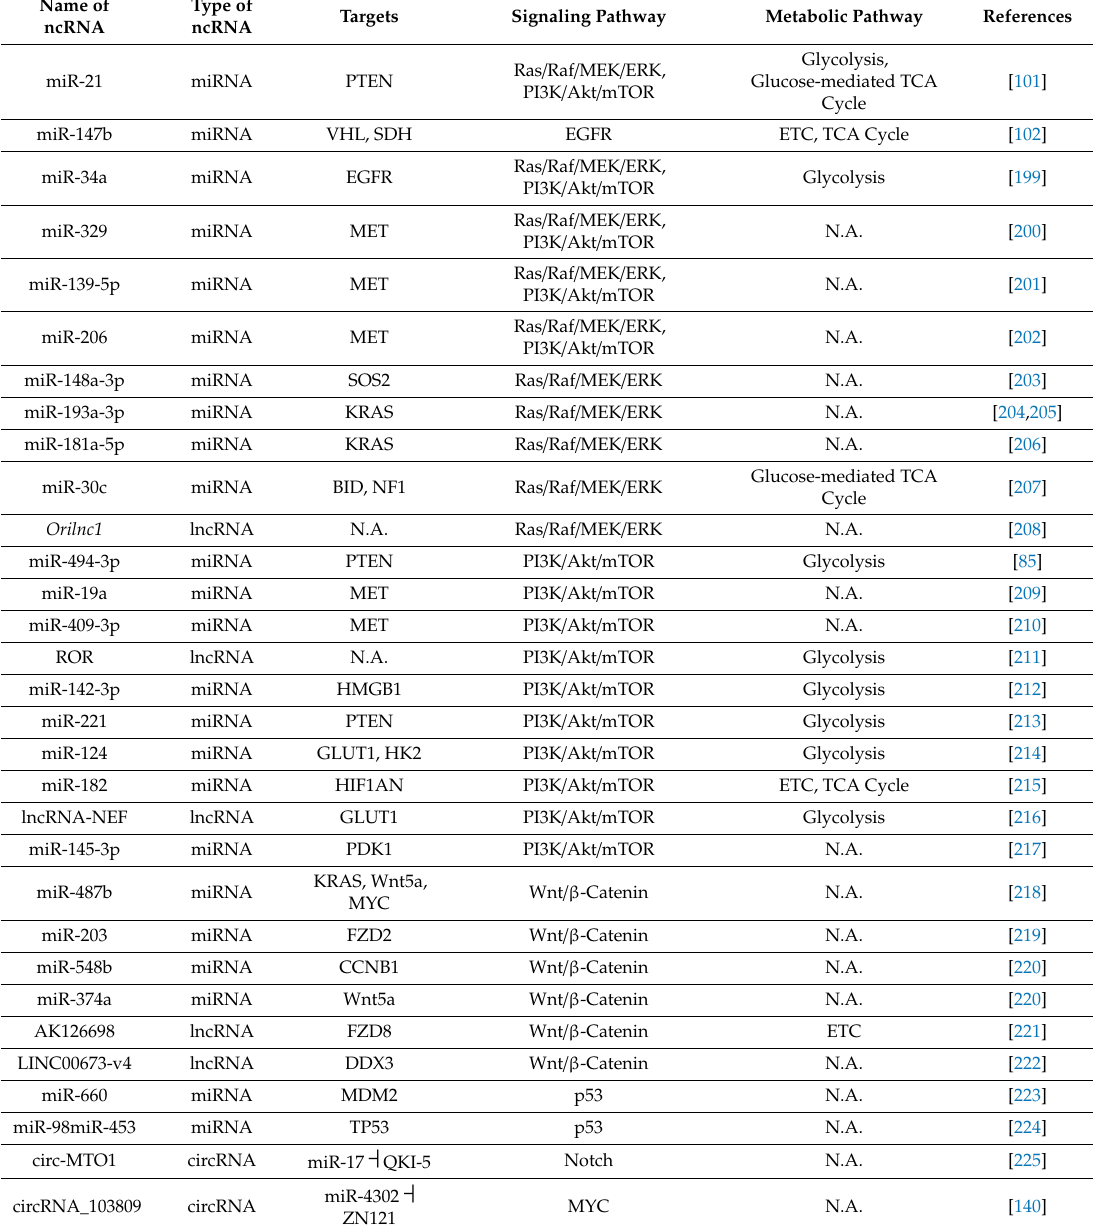
Table 3. Non-coding RNAs that a ff ect cell signaling and metabolic pathways.